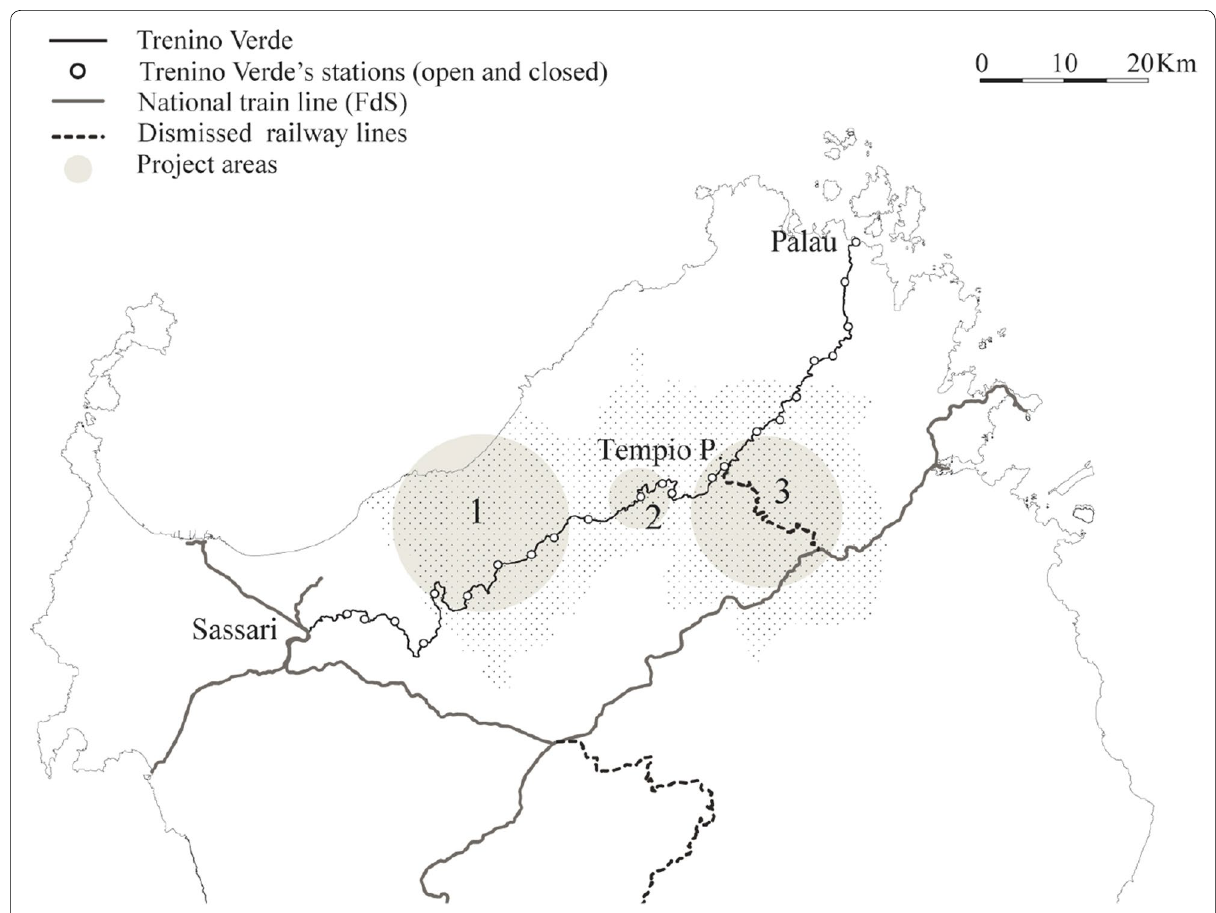
Fig. 8 Masterplan of the